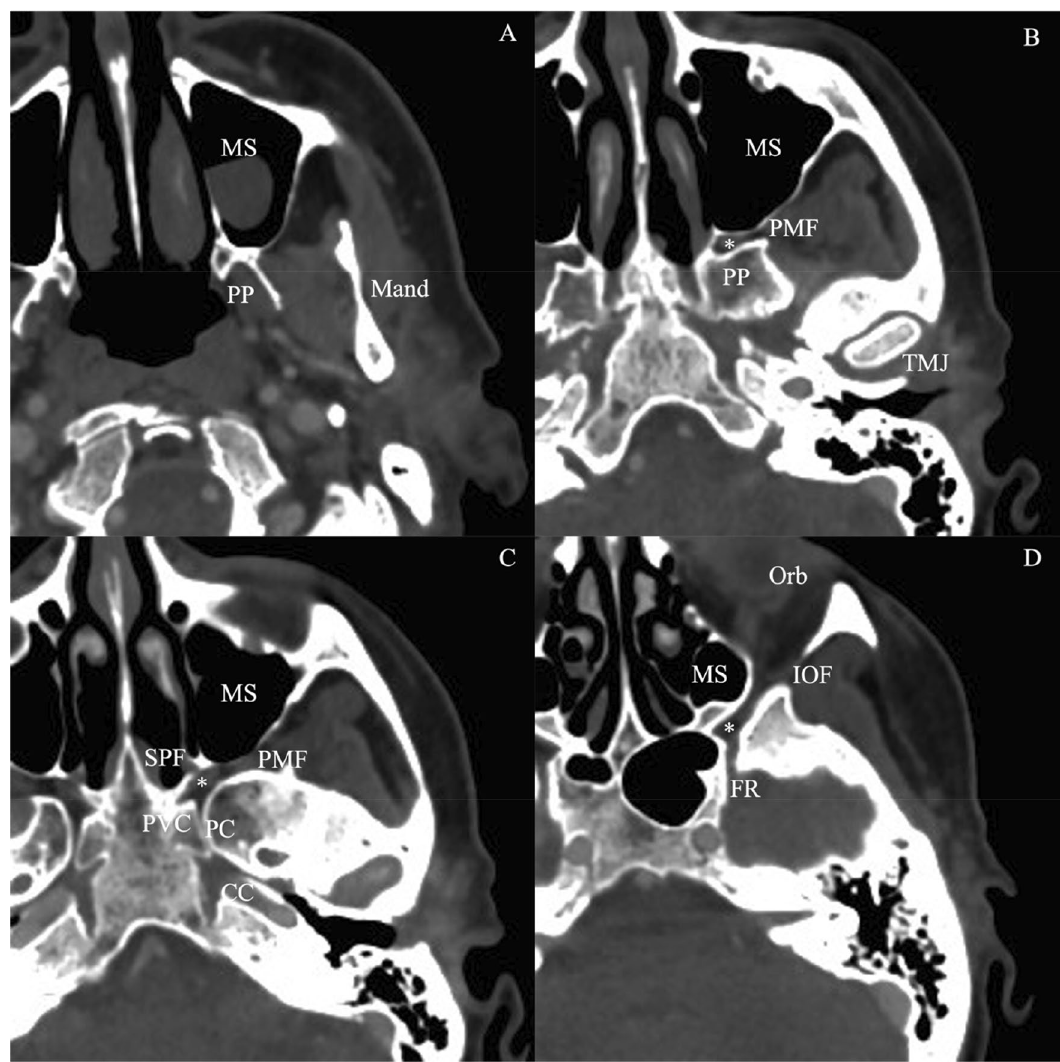
Figure 1. Radiologic anatomy of the pterygopalatine fossa at different levels on axial CT records. ( A ) Immediately above the hard palate, ( B ) at the level of the temporomandibular joint, ( C ) at the level of the carotid canal (petrous segment), ( D ) at the level of the orbit. (WW 1300 ± 80 HU; WL 500 ± 80 HU). CC carotid canal, FR foramen rotundum, HU Hounsfield unit, IOF inferior orbital fissure, Mand mandibula, MS maxillary sinus, Orb orbit, PC pterygoid canal, PMF pterygomaxillary fissure, PP pterygoid process, PVC palatovaginal canal, TMJ temporomandibular joint; *pterygopalatine